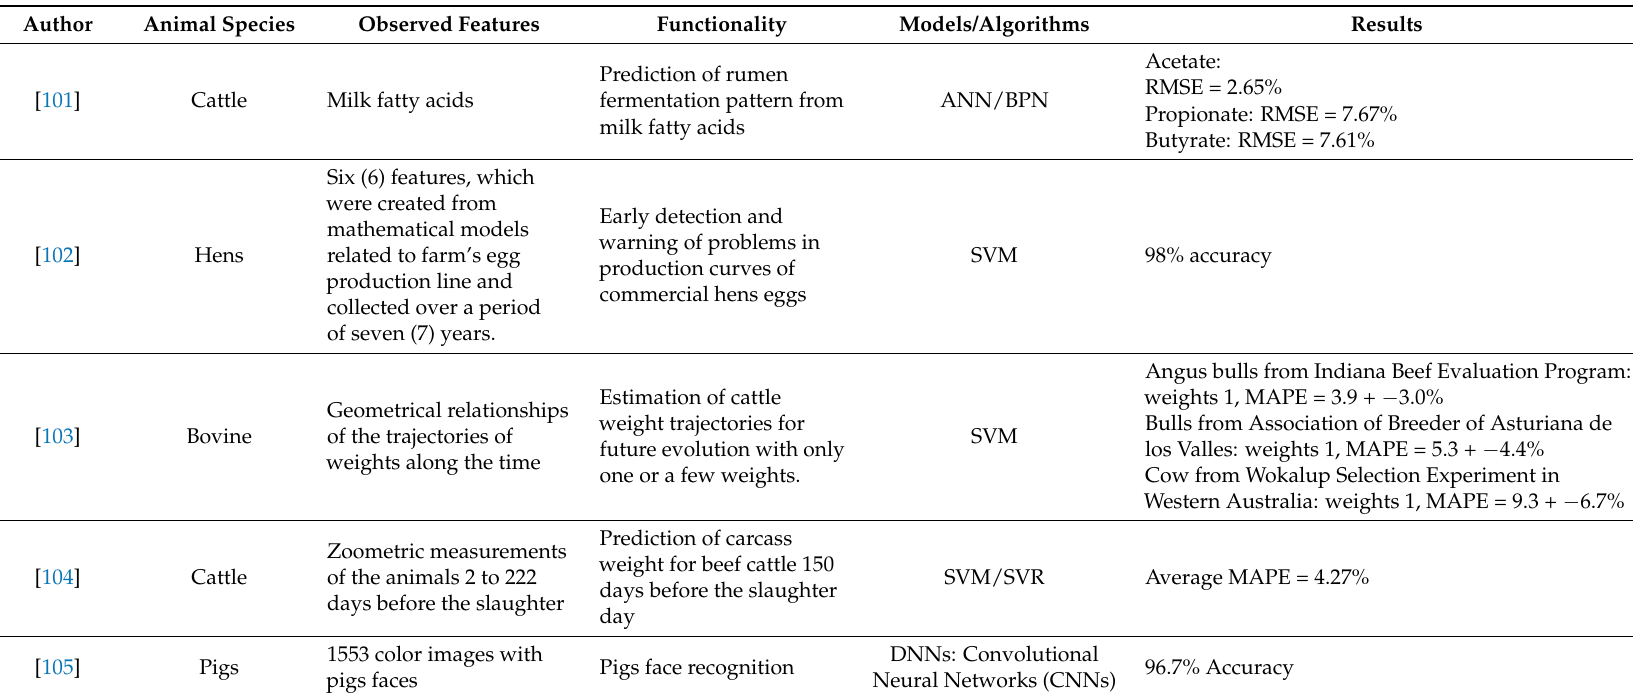
Table 11. Livestock: livestock production